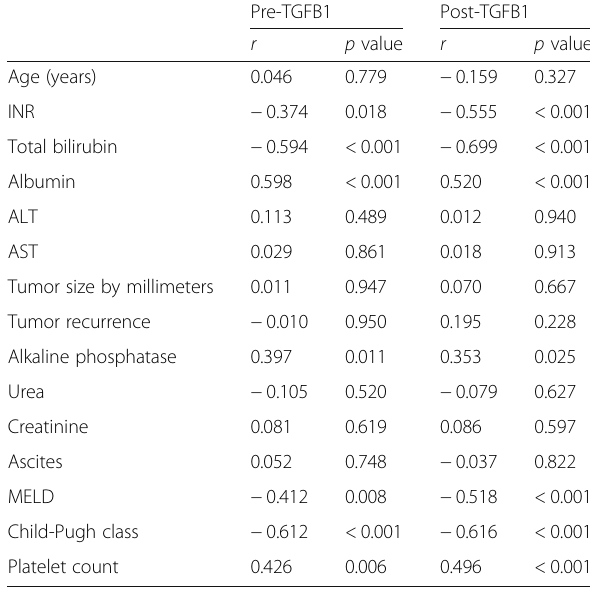
Table 4 Correlation between TGFB1 and other parameters using Pearson ’ s correlation coefficient in the patients ’ group